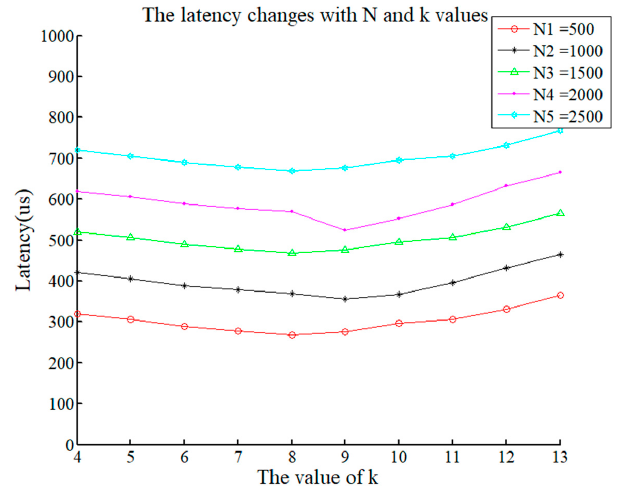
Figure 8. Latency for various values of k .